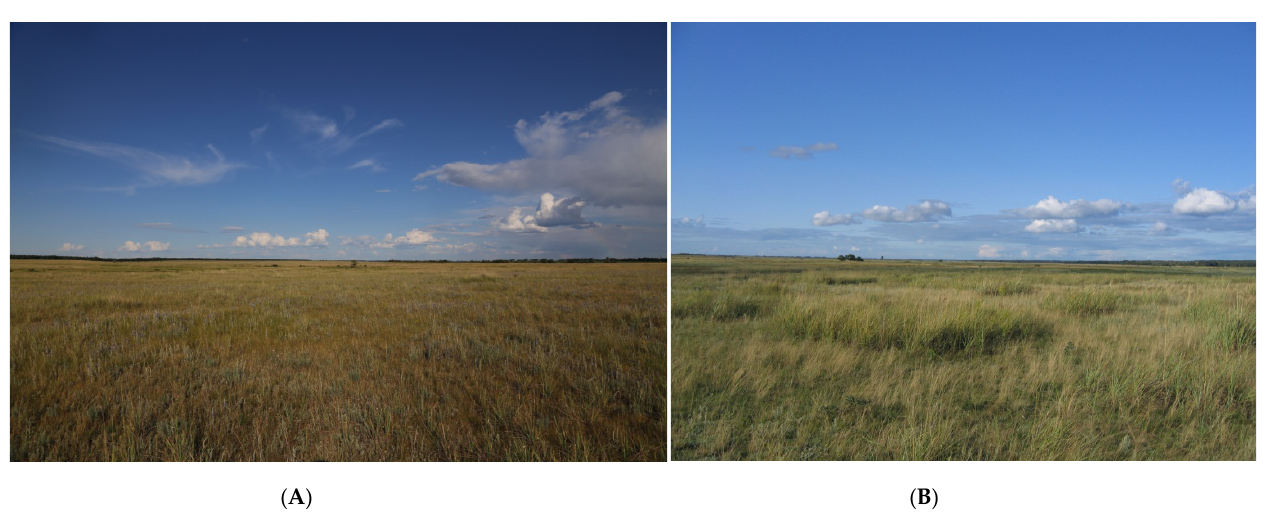
Figure 3. Typical habitats of Oedaleus decorus in the Kulunda steppe: ( A )—typical steppe (near the Kuchuck River, Altai Krai (Altaj Region), 52.41° N 80.03° E); ( B )—dry steppe (near Ust-Volchikha settlement, Altai Krai (Altaj Region), 51.93° N 80.28° E).